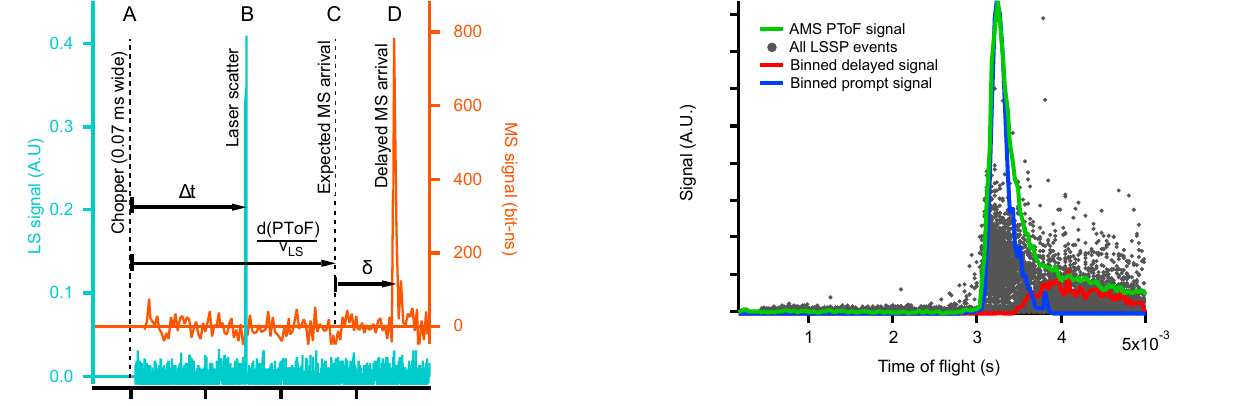
Figure 4. Size distribution comparison between bulk PToF and prompt and delayed single particles. Particle signal versus particle time of flight from the chopper to the mass detector is shown for en- semble mode (green trace) and for all detected single-particle events (gray circles) in a representative SOA experiment (DMA size- selecting SOA particles with mobility diameter = 370nm). Particles are sorted into either prompt or delayed categories based on their delay time. The mass signals for individual particles within each category are binned by flight time and summed to create the prompt (blue trace) and delayed (red trace)